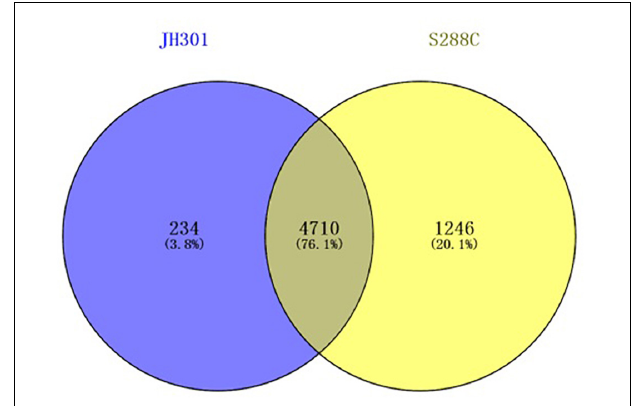
FIGURE 4 | Venn analysis between the genomes of strains JH301 and S288c.